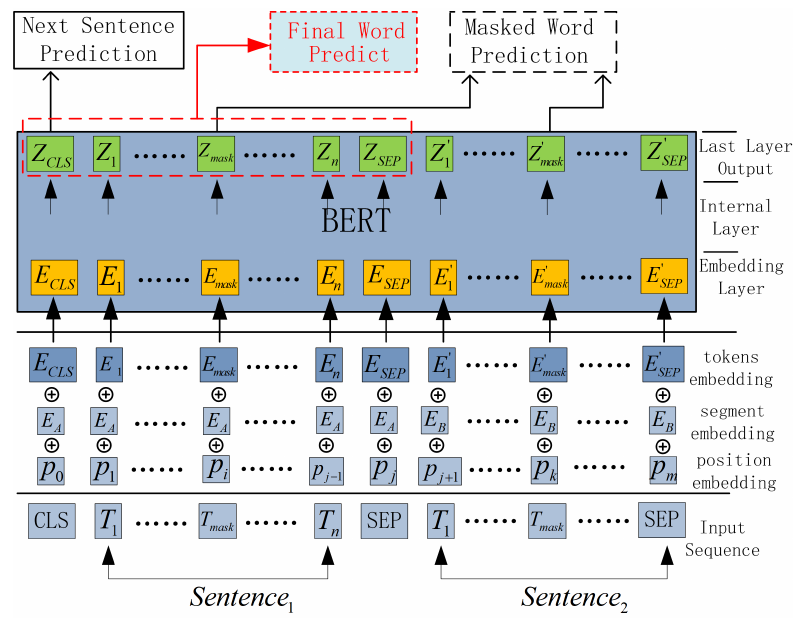
Figure 4. The architecture of SEMTS-BERT. FWP is added to BERT as a sub-task. The total loss of SEMTS-BERT is the sum of Loss fwp , Loss nsp , and Loss mwp , that is, Loss = Loss fwp + Loss nsp + Loss mwp .